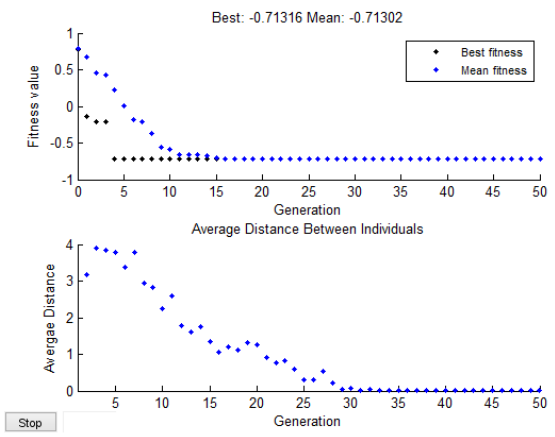
Fig. 10. Best fitness value for :; trajectory and average distance between